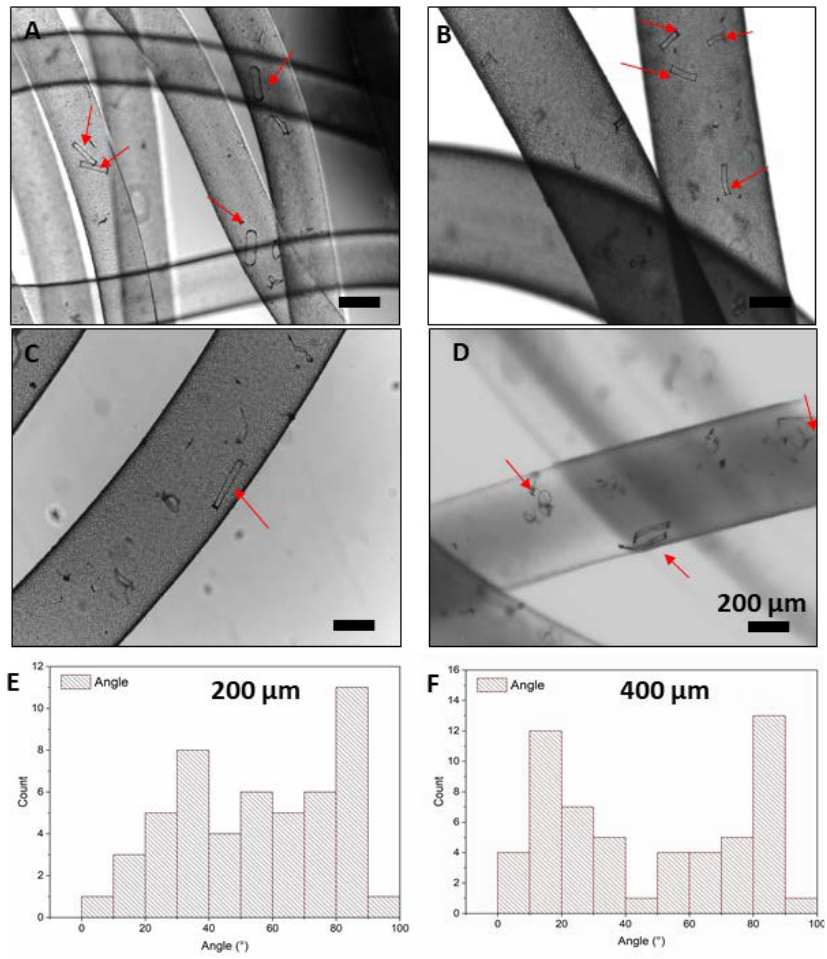
Figure 5. Images taken by optical microscopy show the morphology of the hydrogel-based filaments (ADA-GelMA, 2:1, 10 wt%) with rod-shaped fillers of ( A , B ) 200 and ( C , D ) 400 µm length. These pictures are taken from different spots of the spun filaments. The red arrows spot the rods within the wet spun filaments. Angular distribution for the ( E ) 200 µm and ( F ) 400 µm length microrods (14,000 rods/mL) with respect to the fiber axis.